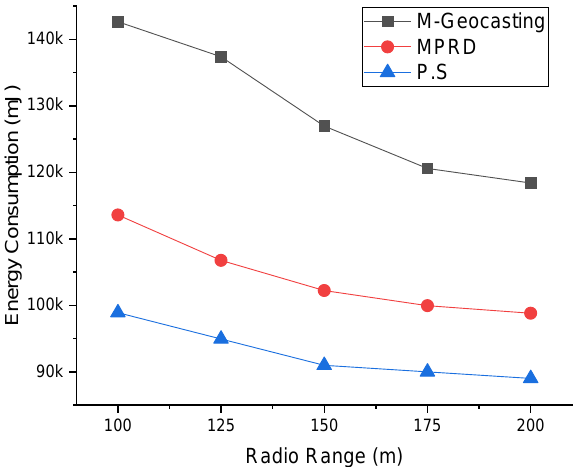
Figure 12. Comparison of energy consumption according to the radio